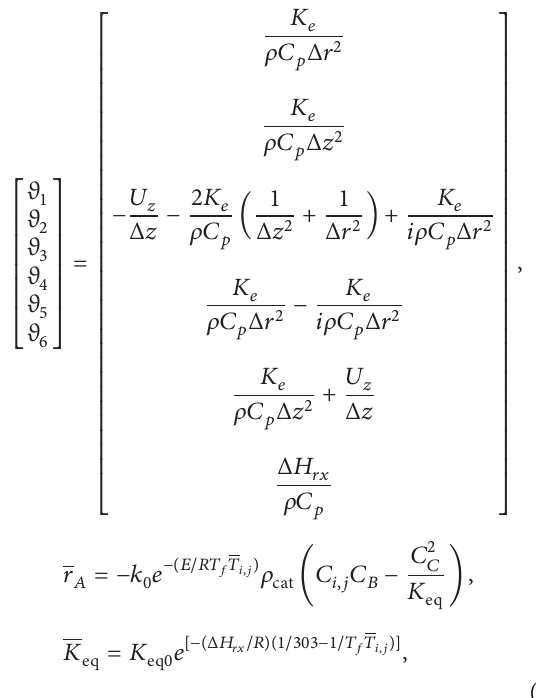
The algorithm was executed in MATLAB with the fol- lowing parameters: 𝑛 = 30 , 𝑚 = 30 , 𝑇 𝑓 = 320 K, 𝐶 𝑓 =